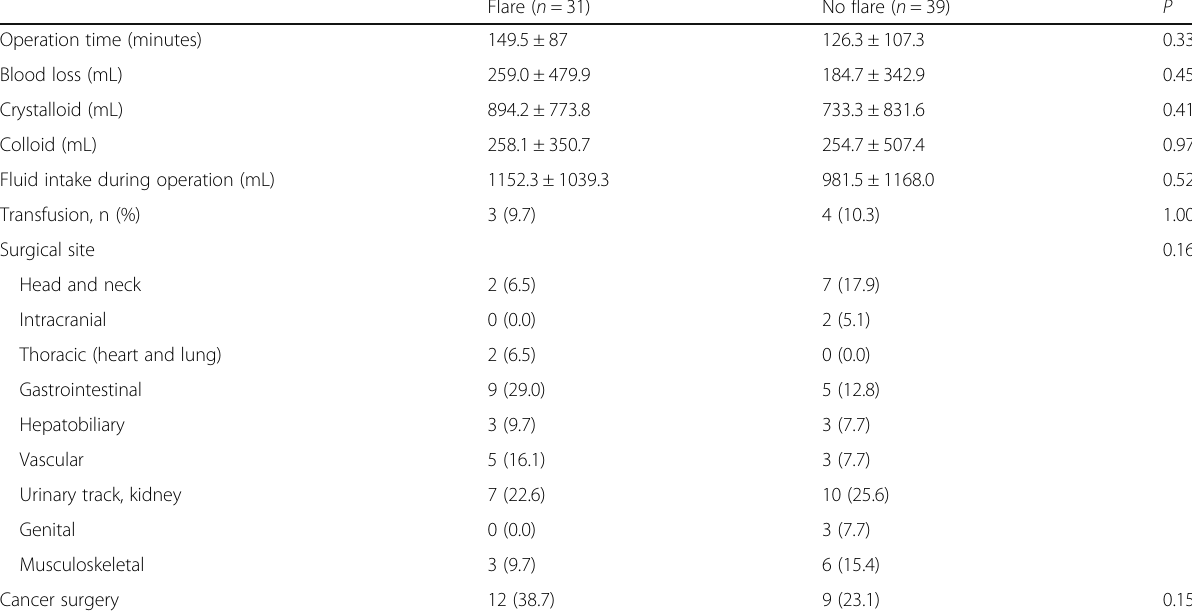
Table 3 Comparison of surgery details between patients with gout flare and without gout flare